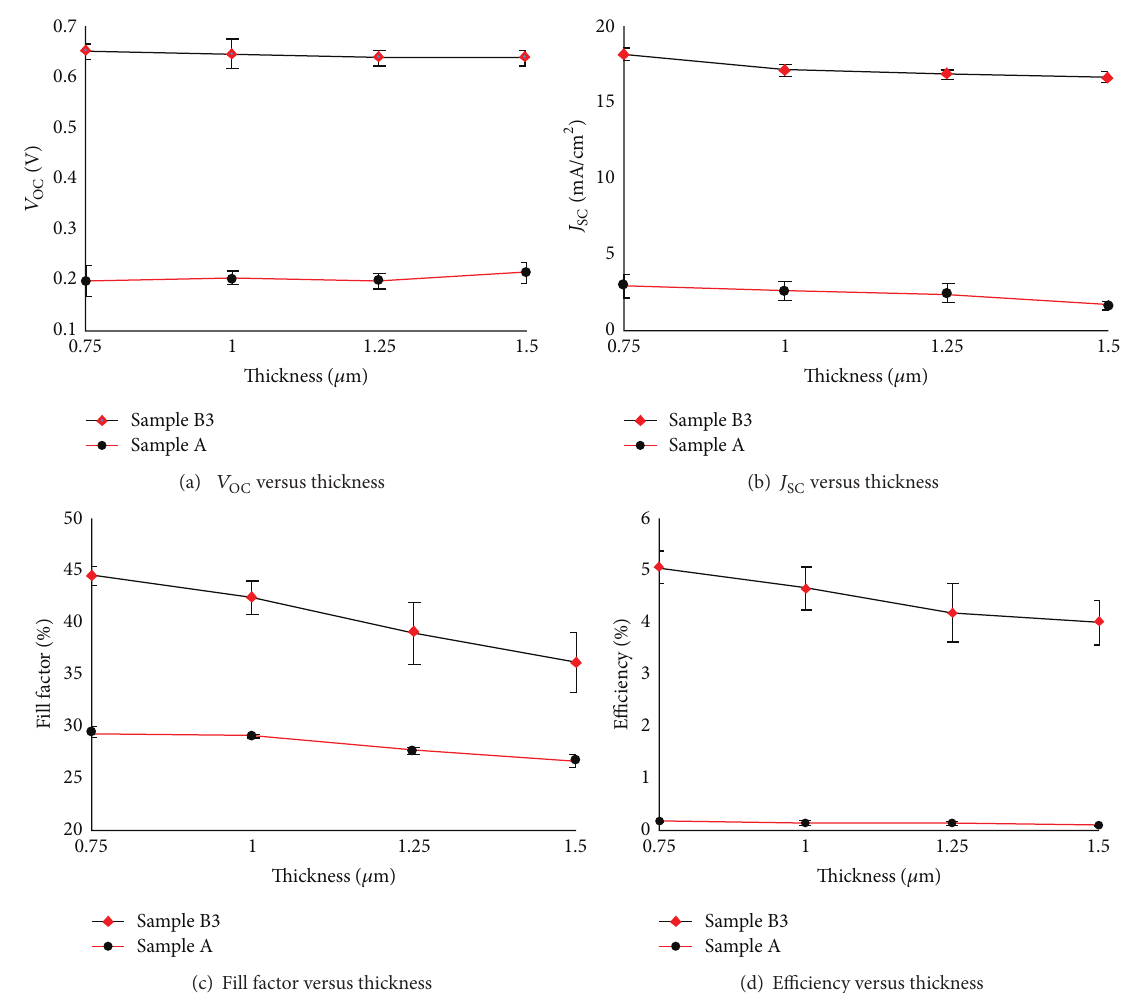
Figure 6: The values of open circuit voltage (a), short circuit current (b), fill factor (c), and efficiency (d) as a function of CdTe thickness for sample A made without any CdCl 2 annealing and sample B3 that underwent a 15 min CdCl 2 annealing.